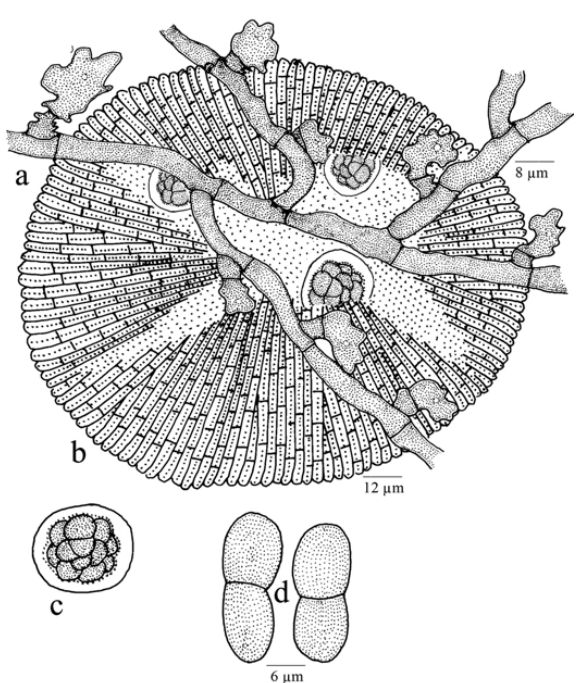
Figure 146. Asterina gymnemae a - Appressorium; b - Thyriothecium; c - Ascus; d -